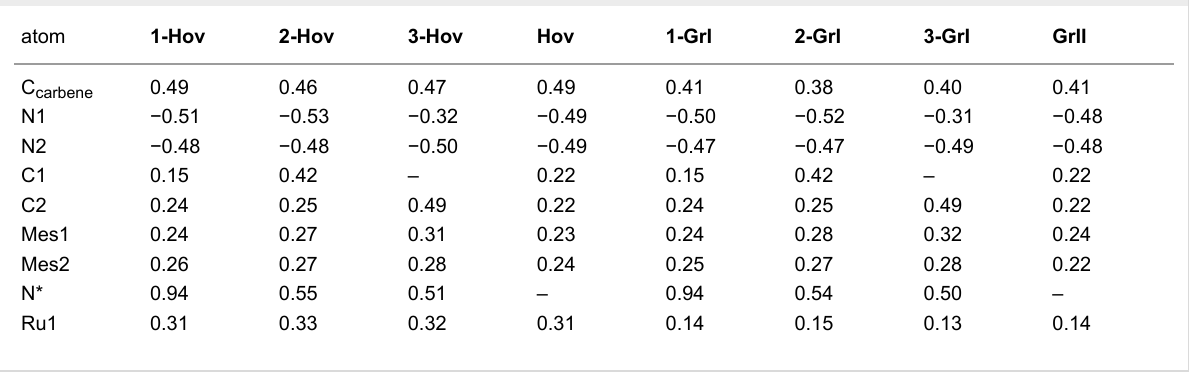
Table 5: Natural partial charges distribution in carbenes of 1 – 3-Hov and 1 – 3-GrI .